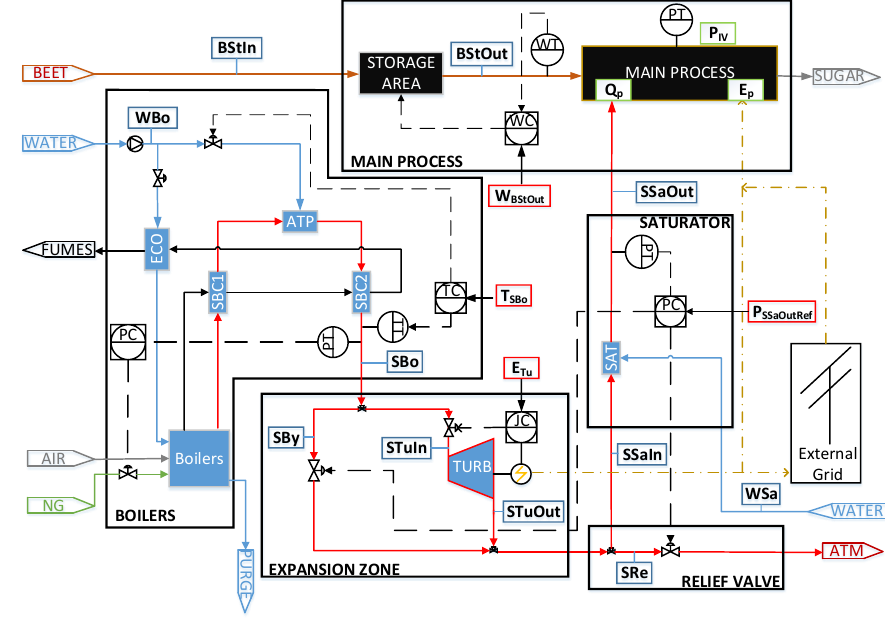
Figure 1. Schematic of the whole